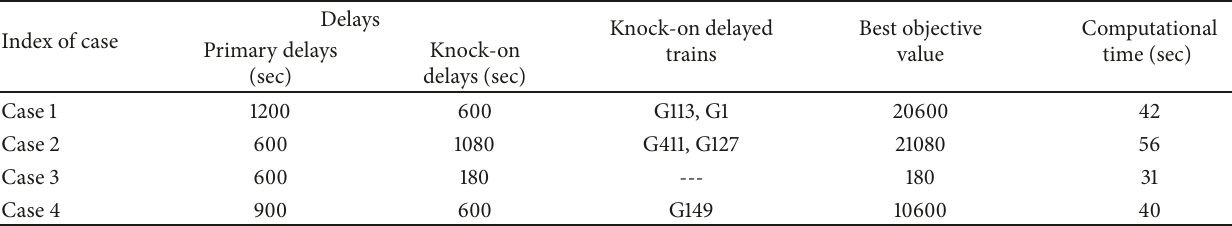
Table 5: Results of delay